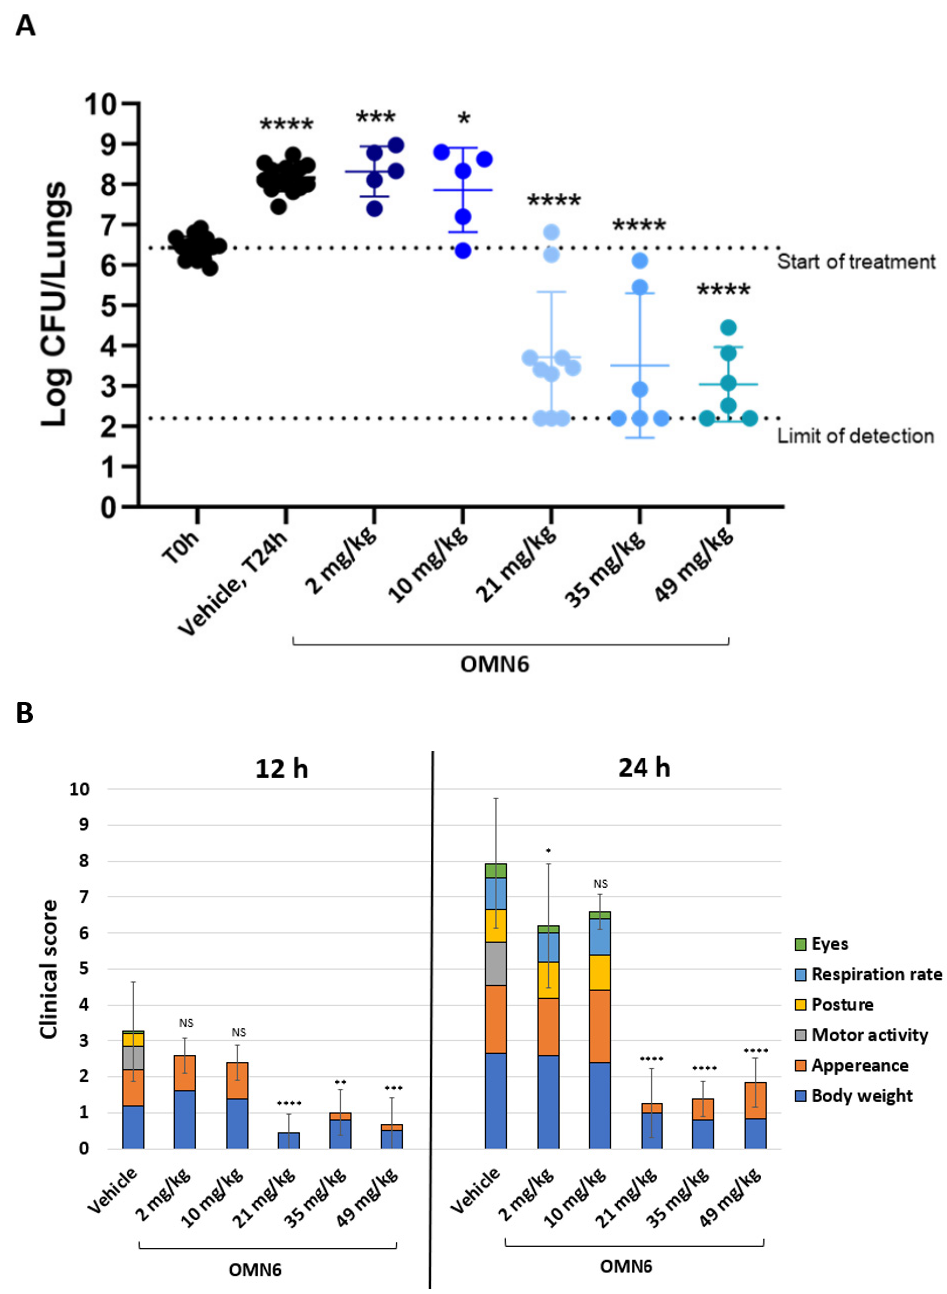
Figure 3. Bacterial burden in a mouse lung infection model induced by an MDR AB clinical isolate.